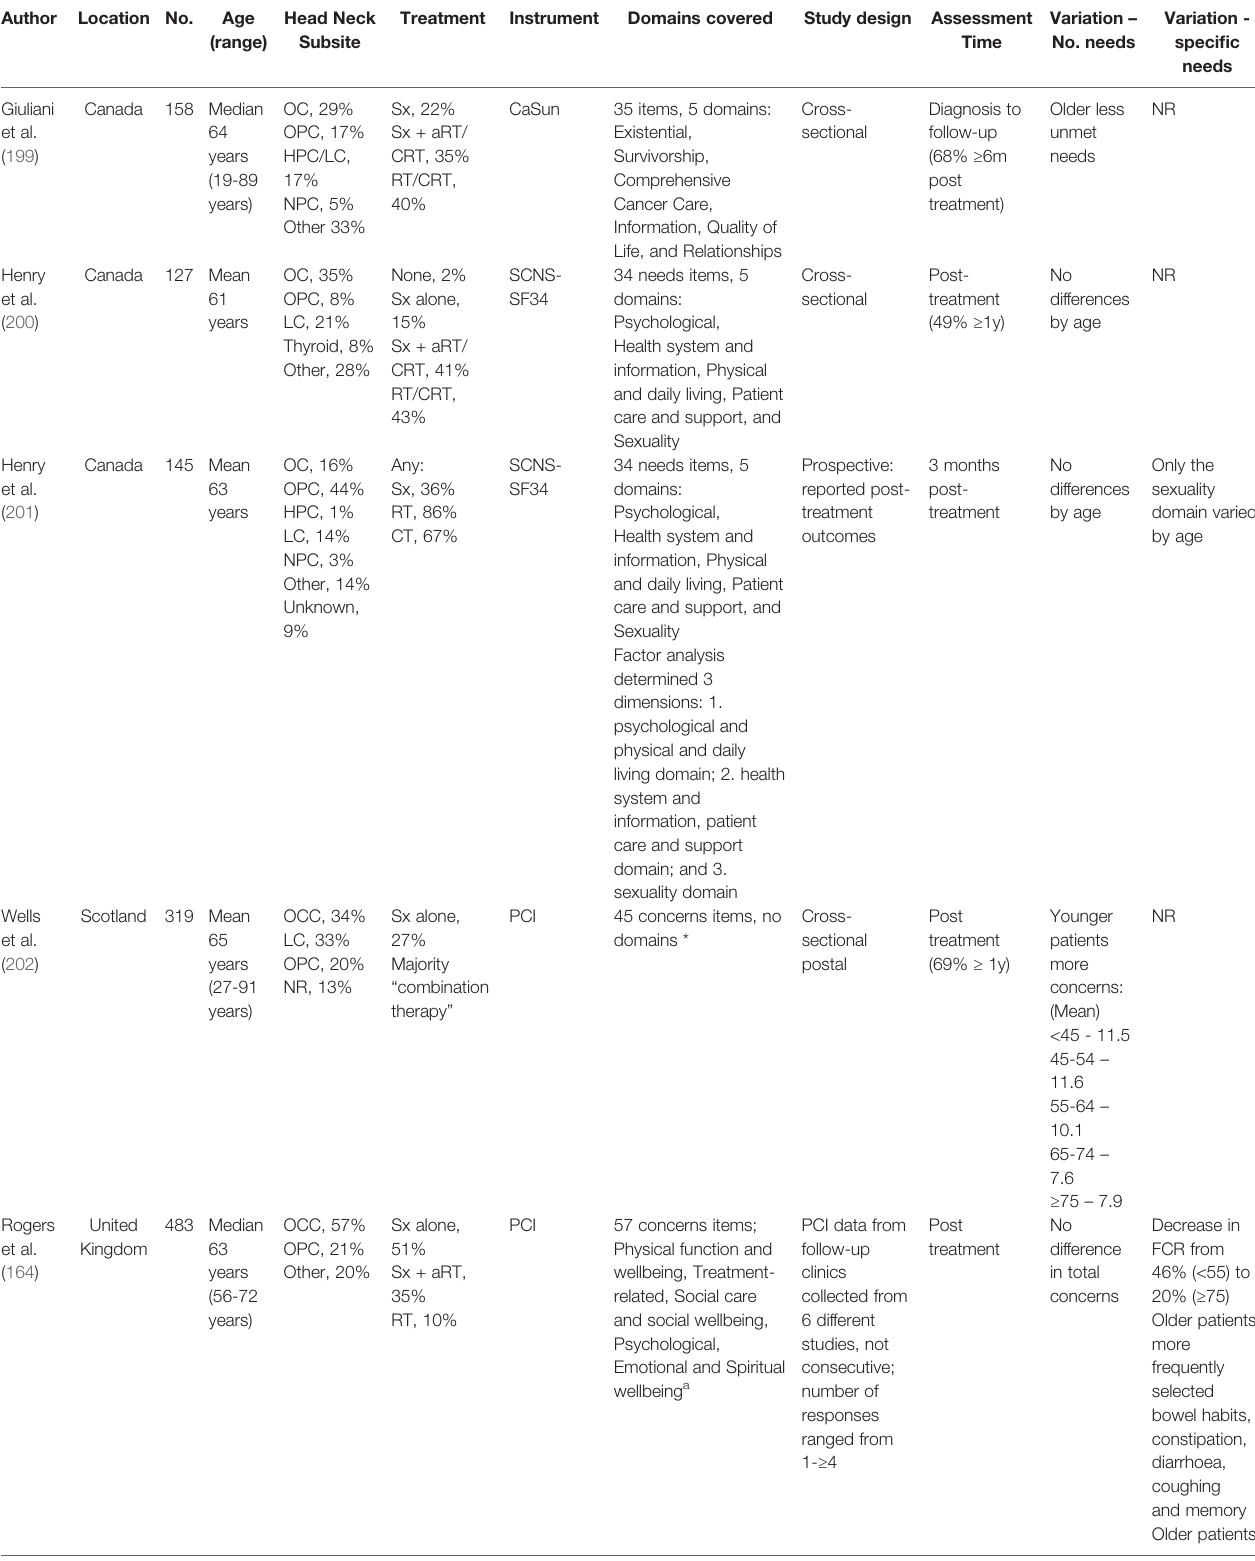
TABLE 12 | Studies reporting variations in unmet needs by age in HNC patients. Author Location